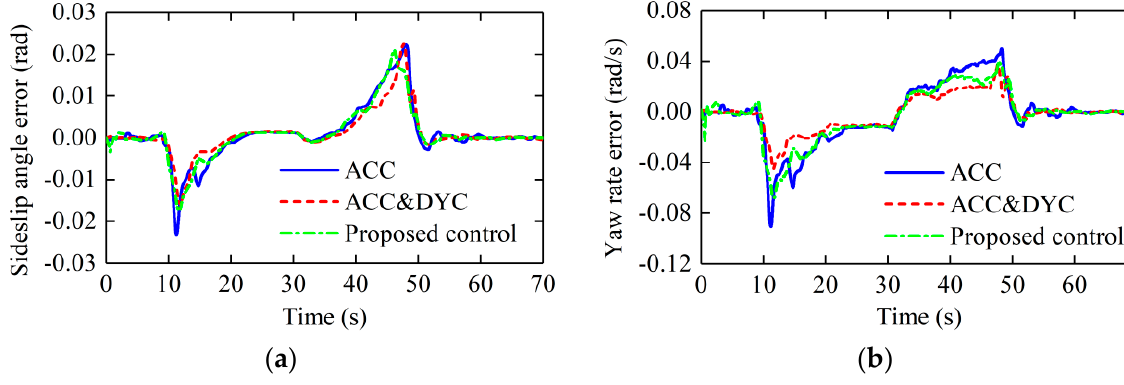
Figure 14. Lateral stability errors: ( a ) vehicle sideslip angle error; ( b ) yaw rate error.